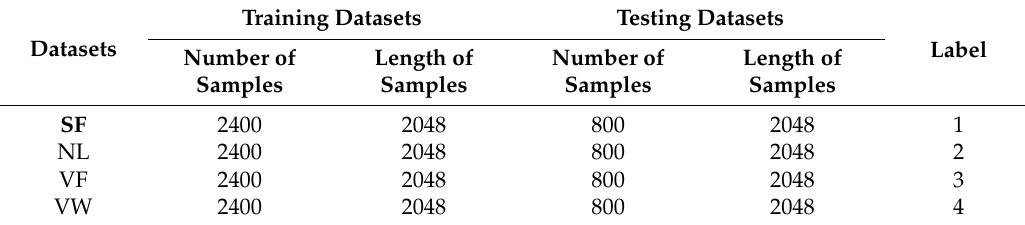
Table 1. Information of the training datasets and testing datasets.